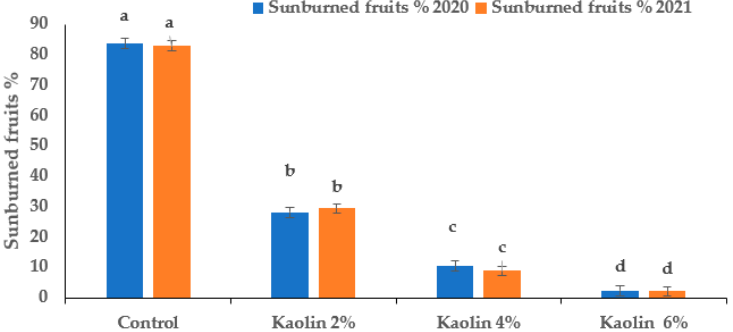
Figure 9. Effect of kaolin spray on sunburned fruits % of Keitt mango cultivar during the seasons 2020 and 2021. Bars indicate mean values ± SE (n = 9). Different letters above columns indicate significant differences among pruning treatments at p = 0.05 according to Bartlett’s test.